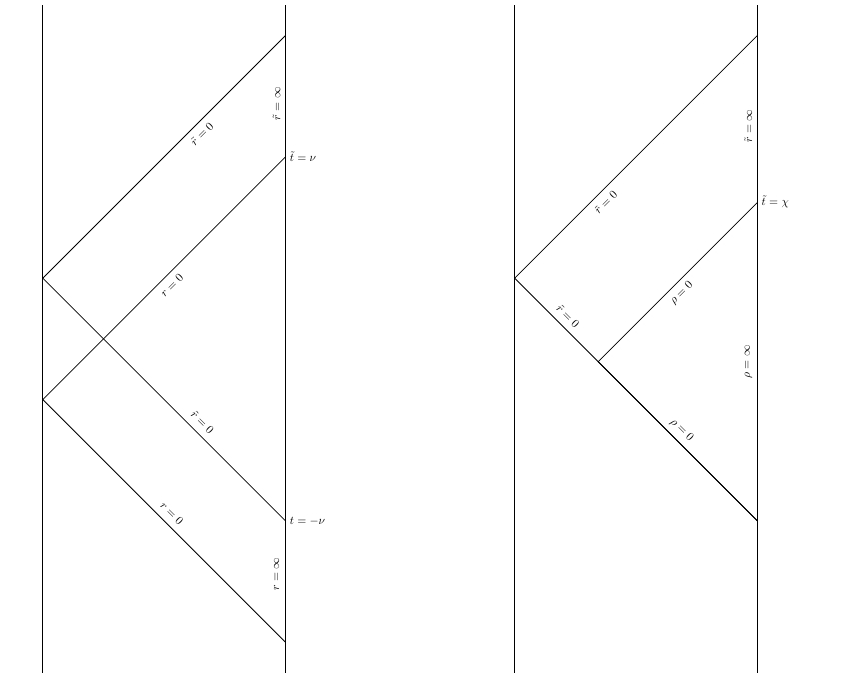
Figure 4 . Penrose diagrams of AdS 2 × S 2 . Left: the two Poincaré patches are related by a global time translation according to the transformation (A.1). Right: the Poincaré and Rindler patches are situated according to the transformation